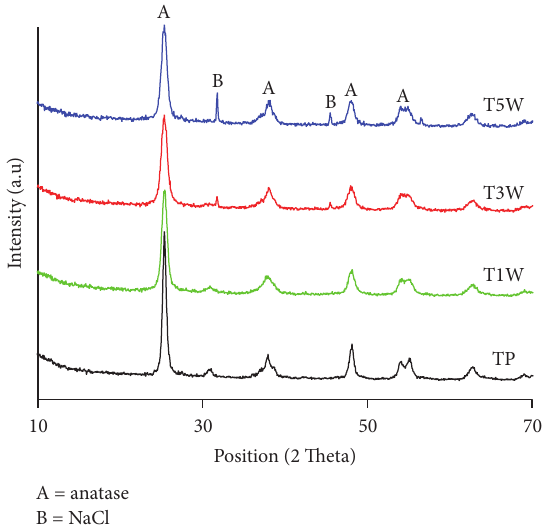
Figure 1: The XRD patterns of WO 3 -doped TiO 2 .